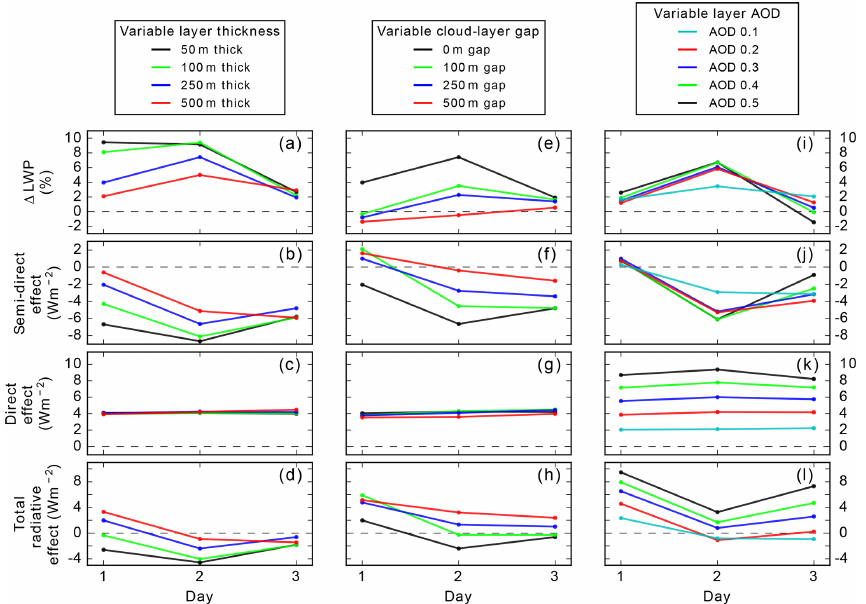
Figure 8. Daily mean radiative impact on the elevated aerosol layer properties over the initial 3d following the introduction of the aerosol layer for systematic changes to (a–d) aerosol layer thickness, (e–h) cloud–aerosol gap, and (i–l) aerosol optical depth of